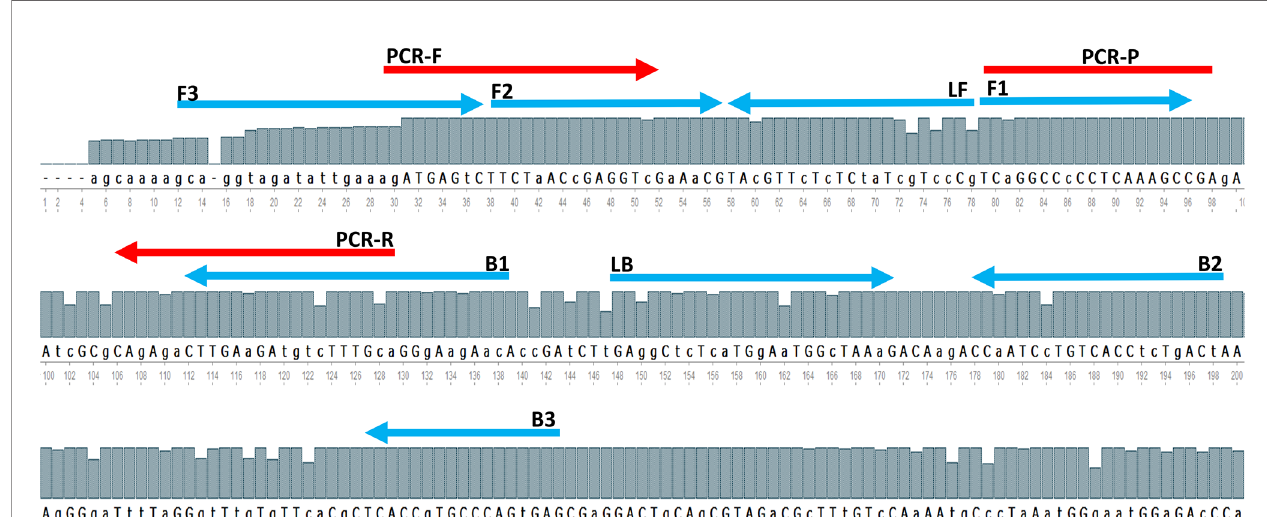
FIGURE 1 | A The partial consensus sequence of AIV M-gene and the location of designed RT-LAMP primers (blue arrow) and referenced method rRT-PCR primers and probe (red